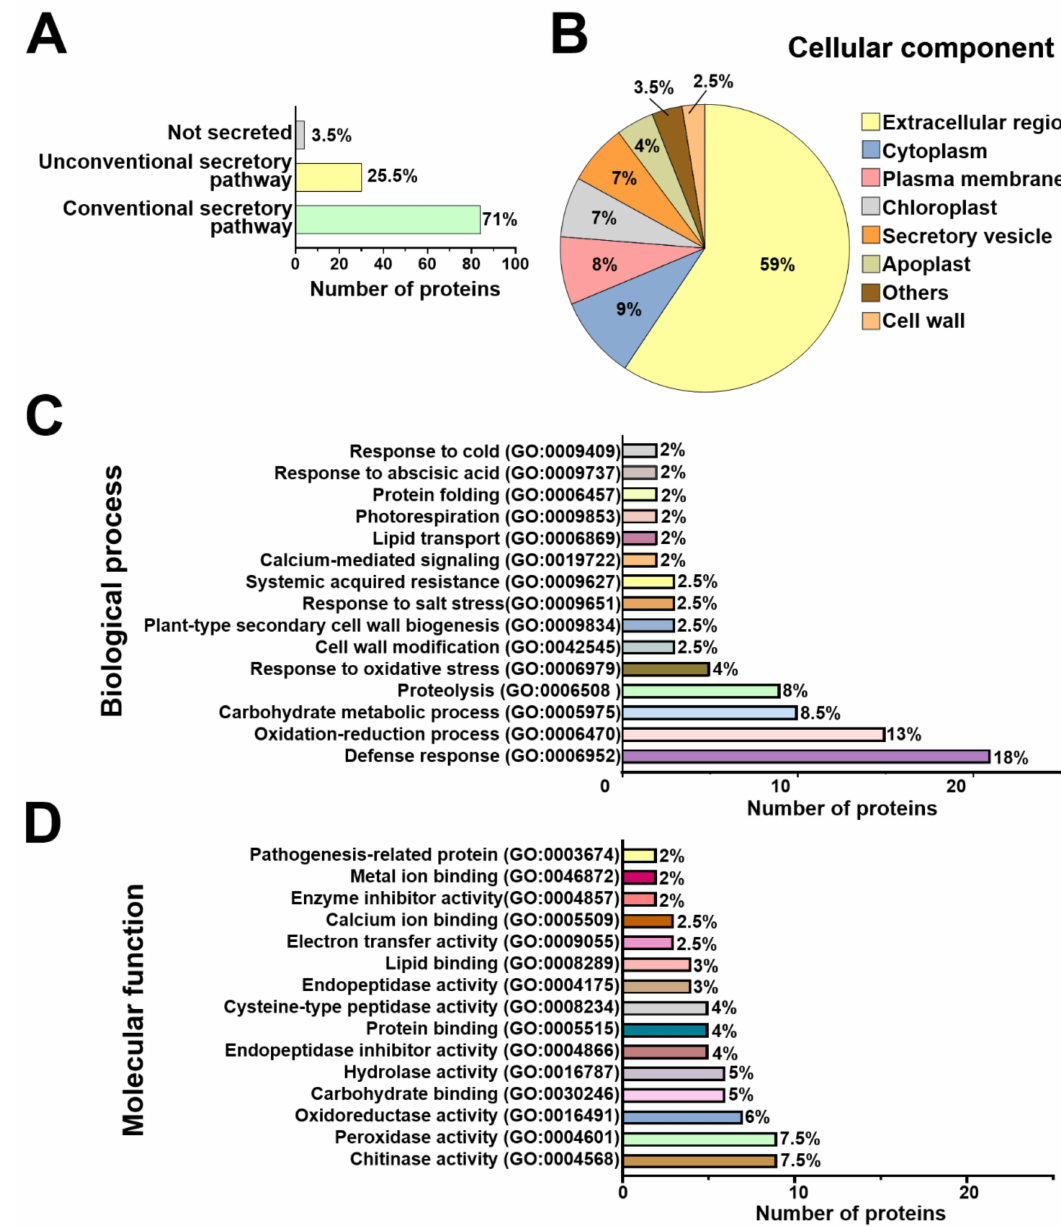
Figure 3. Prediction of putative secretion pathways and functional annotation of Arabidopsis secreted proteins. ( A ) Prediction of secretion pathways for Arabidopsis proteins during its interaction with T. atroviride . ( B ) Pie chart for the cellular component of Arabidopsis secreted proteins. Others include the vacuole, endoplasmic reticulum, and nucleus predicted. ( C ) Horizontal bar graphic for the top 15 biological processes of Arabidopsis secreted proteins predicted. Bars represent the number of proteins implied in a specific biological process. ( D ) Horizontal bar graphic for the top 15 molecular functions predicted. Prediction of secretion pathways was performed using SECRETOOL [29], SecretomeP v2.0 [30], and OutCyte v1.0 [31]. Functional annotation was performed with Gene Ontology (GO) terms using the Blast2GO software